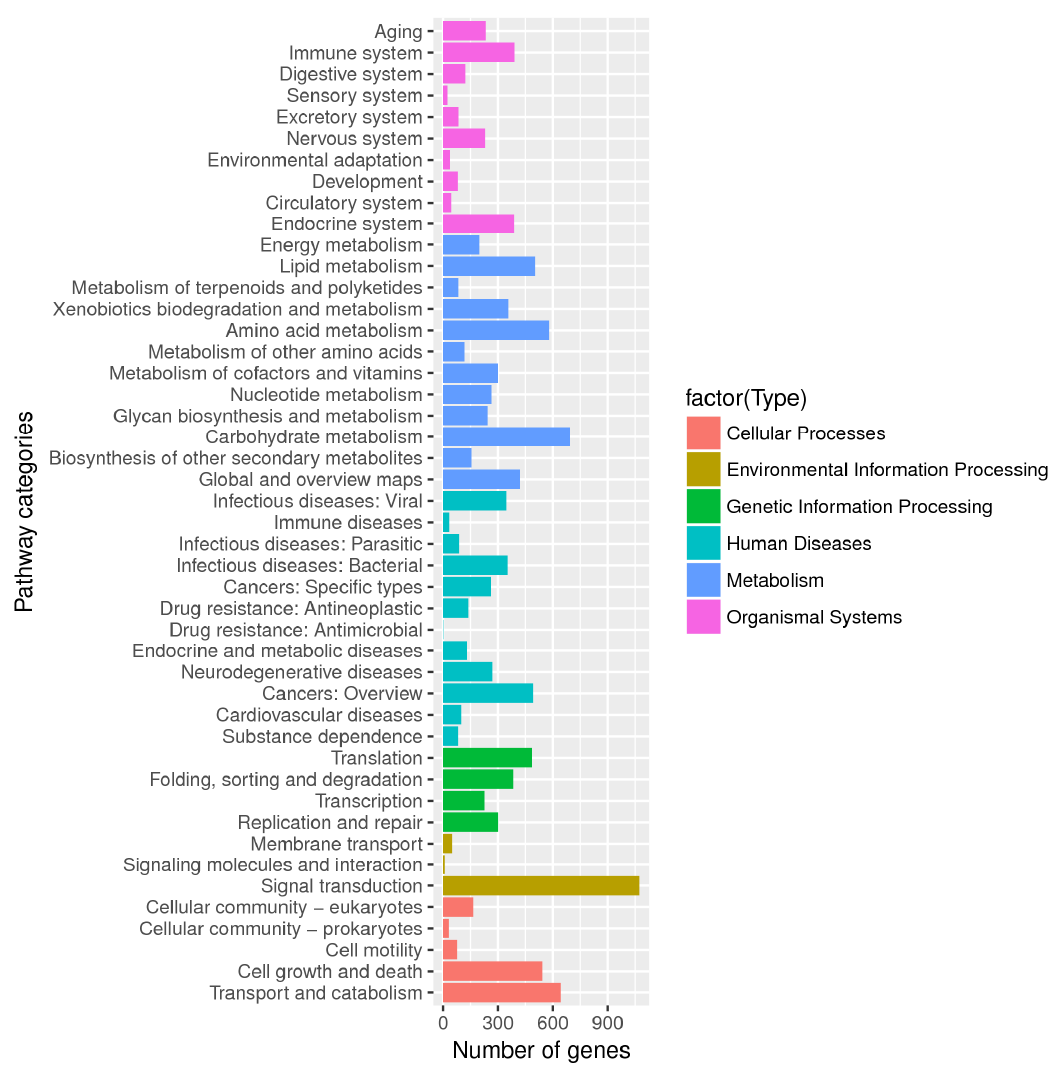
Figure 6. The KEGG function annotation of C. unicolor SP02. Distribution of genes in different KEGG categories. A total of 1193 CAZyme ‐ coding genes of SP02 were annotated, included 402 Gly ‐